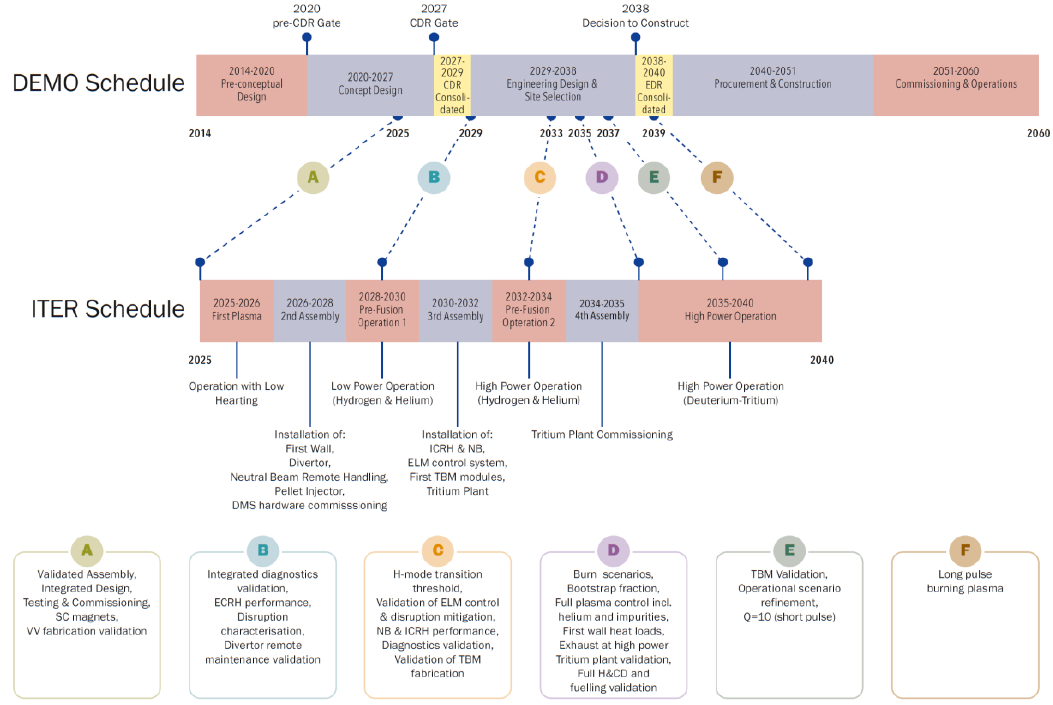
Figure 1. Overview of the European Roadmap to the realization of Fusion Energy [4]. The reported dates are still indicative.